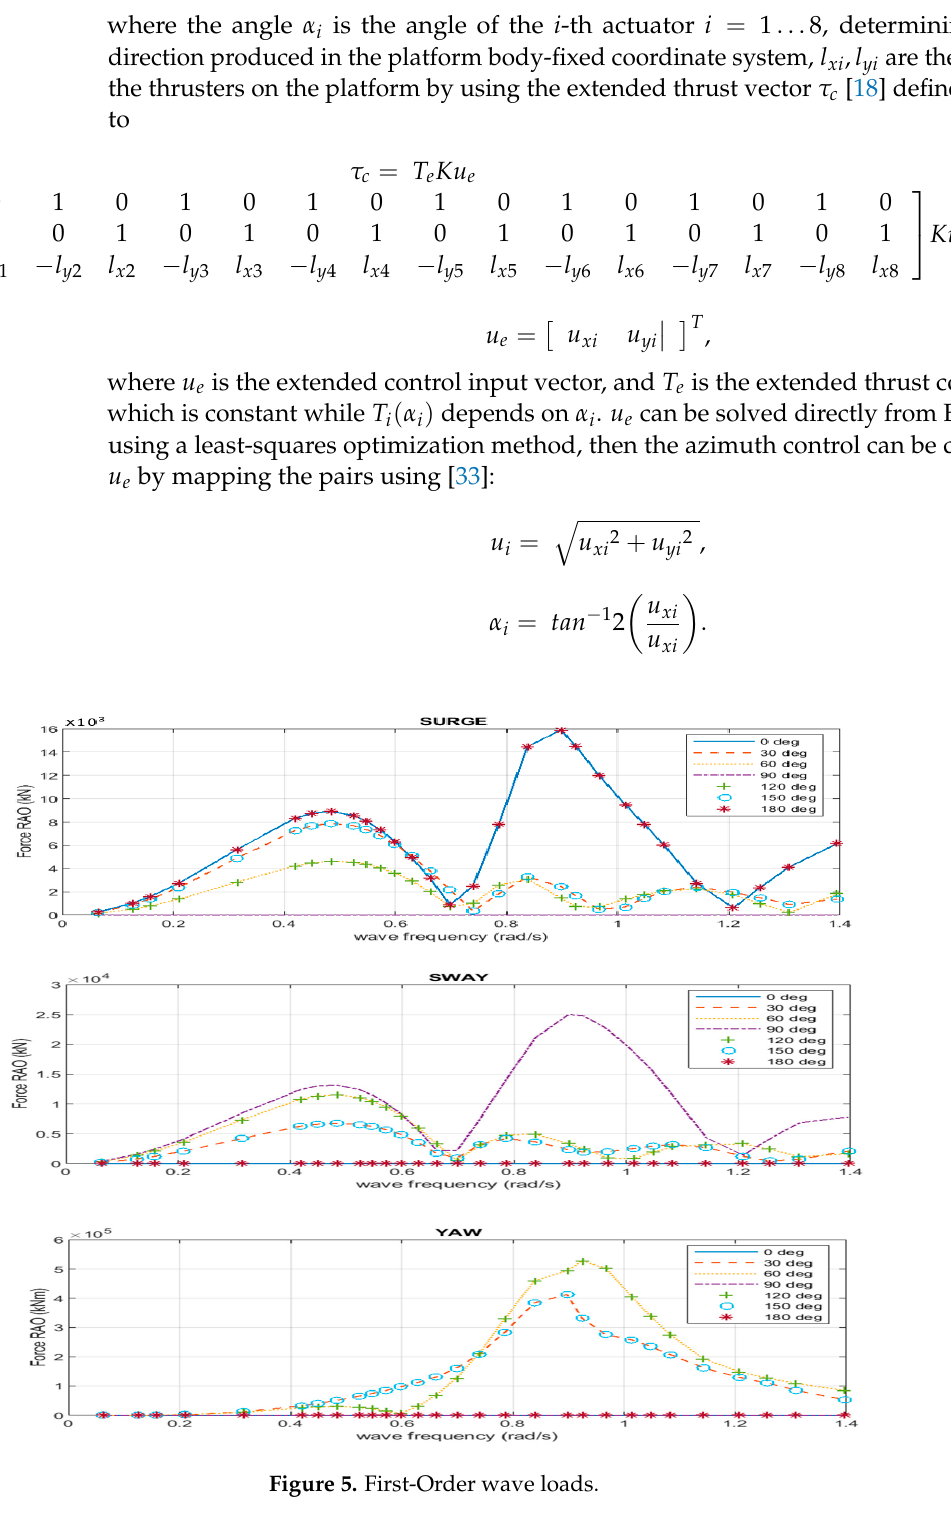
Figure 6. Second-Order wave loads. 𝜏 (cid:3047)(cid:3035)(cid:3045) = (cid:3429)𝑋 (cid:3047)(cid:3035)(cid:3045) 𝑌 (cid:3047)(cid:3035)(cid:3045) 𝑁 (cid:3047)(cid:3035)(cid:3045) (cid:3433) = 𝑇 (cid:2871)(cid:3051)(cid:2876) (𝛼)𝑓 (cid:2869)(cid:3051)(cid:2876) = 𝑇 (cid:2871)(cid:3051)(cid:2876) (𝛼)𝐾 (cid:2876)(cid:3051)(cid:2876) 𝑢 (cid:2869)(cid:3051)(cid:2876) ,